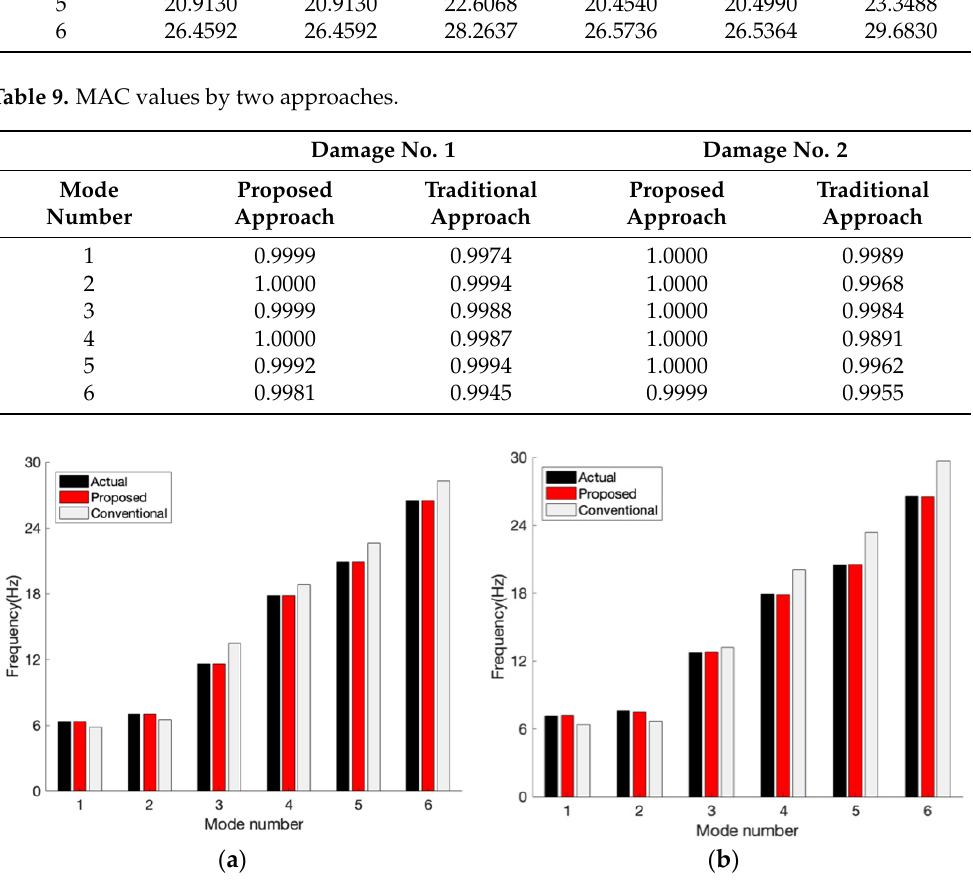
Figure 9. Updated frequencies by two approaches: ( a ) damage case No. 1; ( b ) damage case No.